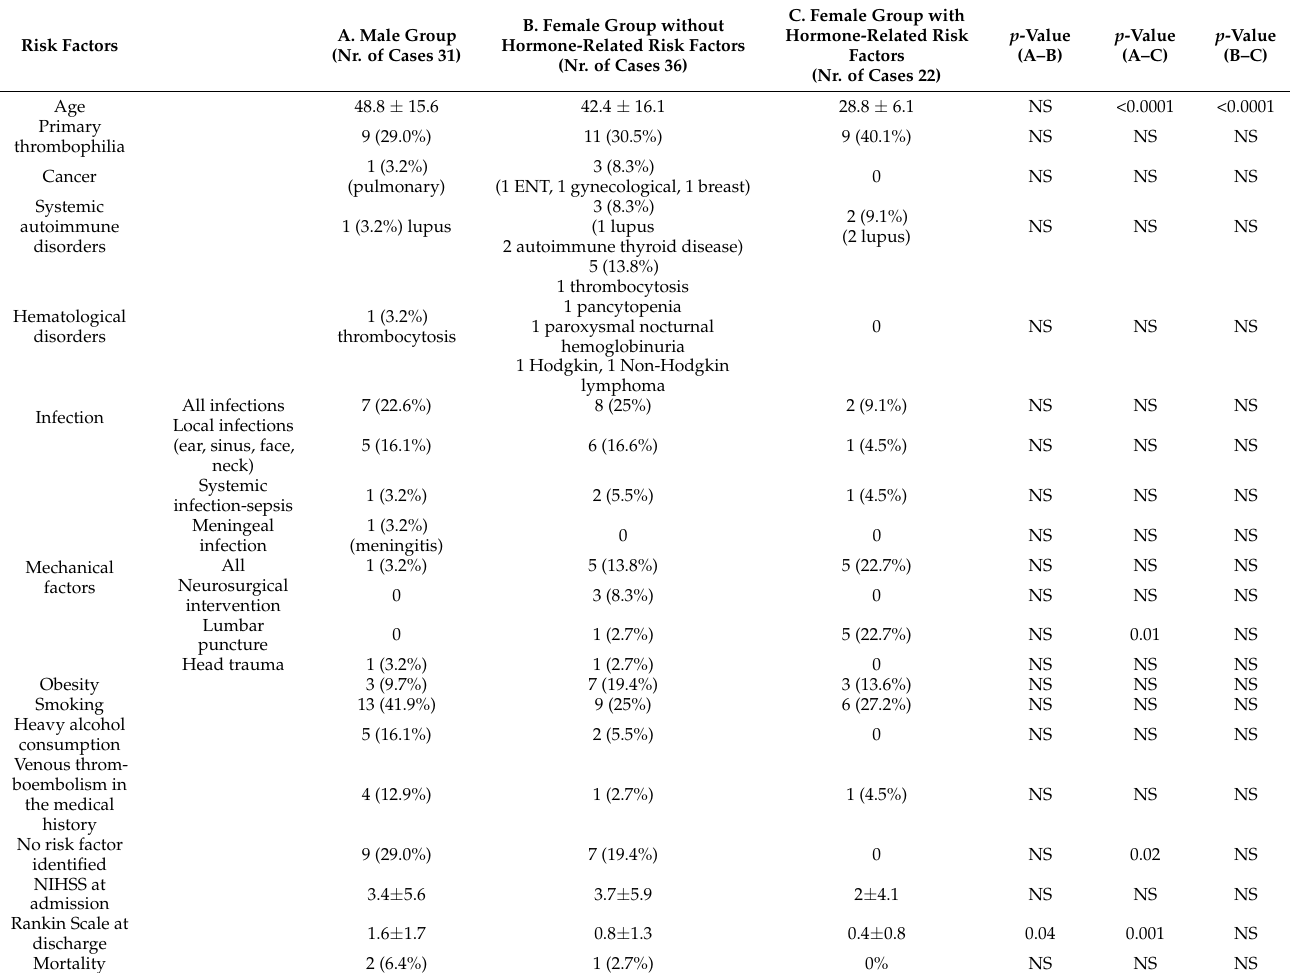
Table 3. Risk factor profile and clinical characteristics in male group and female subgroups: females without hormone- related risk factors and females with hormone-related risk